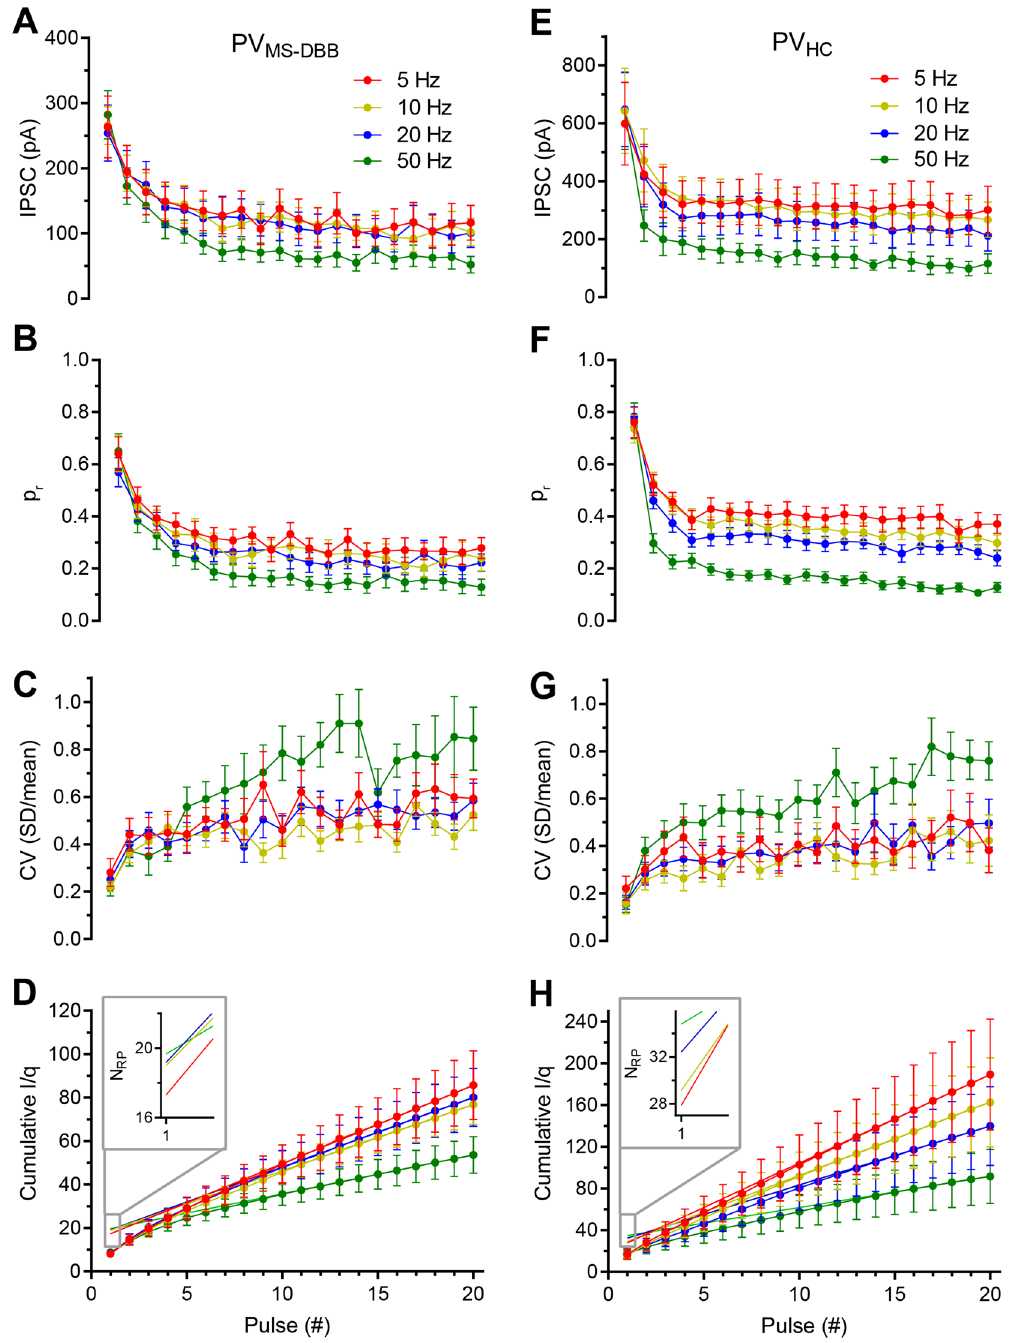
Figure 5. Frequency-dependence of PV MS-DBB and PV HC -mediated transmission. ( A ) PV MS-DBB IPSC amplitude induced by optogenetic stimulation at 5 Hz (red), 10 Hz (yellow), 20 Hz (blue), and 50 Hz (green). ( B ) Release probability ( p r ; IPSC amplitudes divided by Nq) across the P1–P20 pulse train at different frequencies. ( C ) Coefficient of variation (CV; SD/mean) for 5–50 Hz frequencies. ( D ) Cumulative ISPC amplitude (I) divided by quantal amplitude (q) for 5-50 Hz frequencies. Inset, linear fitting from last 5 pulse estimate the number of release sites at the intercept. ( E – H ) IPSC amplitude, p r , CV, and cumulative I/q for PV HC neurons with the same format as ( A – D